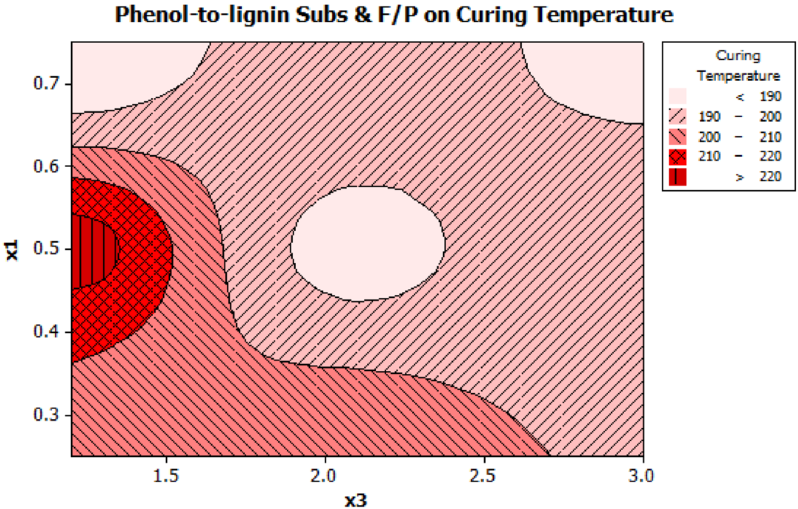
Figure 15. Contour plot for substitution of phenol with lignin (X 1 ) and F/P (X 3 ) on curing temperatures of BPF resoles.